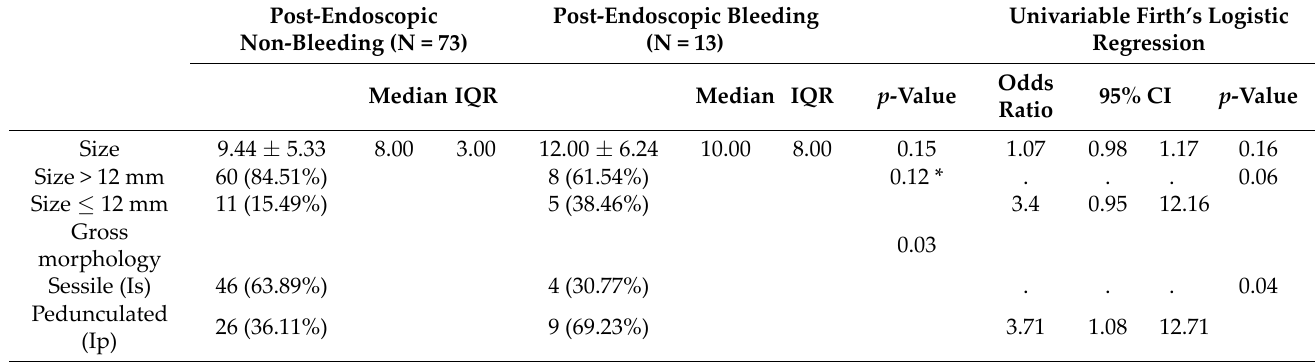
Table 4. Polyp‑related characteristics in post‑colonoscopic polypectomy bleeding (N =